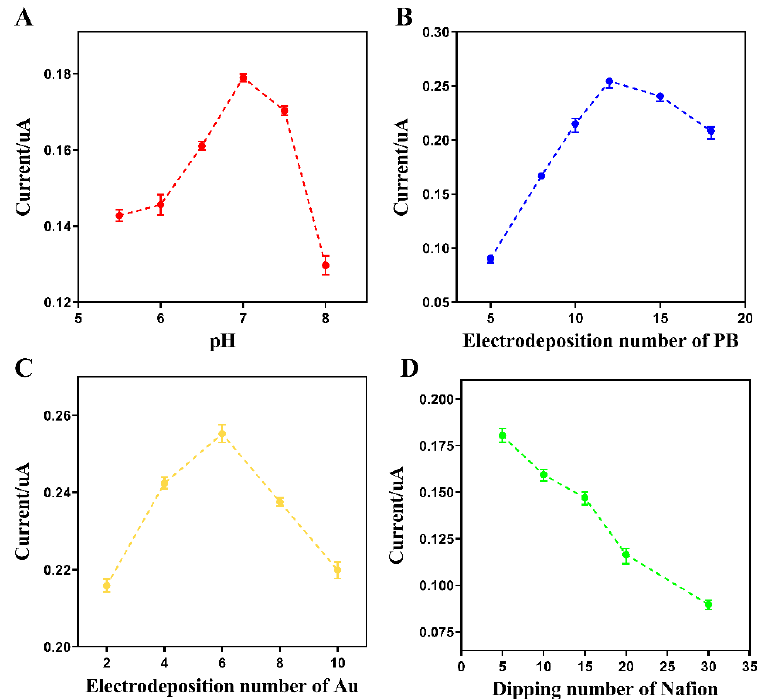
Figure 3. Variable optimization on the experimental conditions for the detection of glutamate (mean ± standard deviation (SD), n = 3). The corresponding response of the modified electrode through the relevant optimization of ( A ) the buffer pH, ( B ) the electrodeposition number of Prussian blue, ( C ) the electrodeposition number of gold, and ( D ) the dipping number in the Nafion solution.